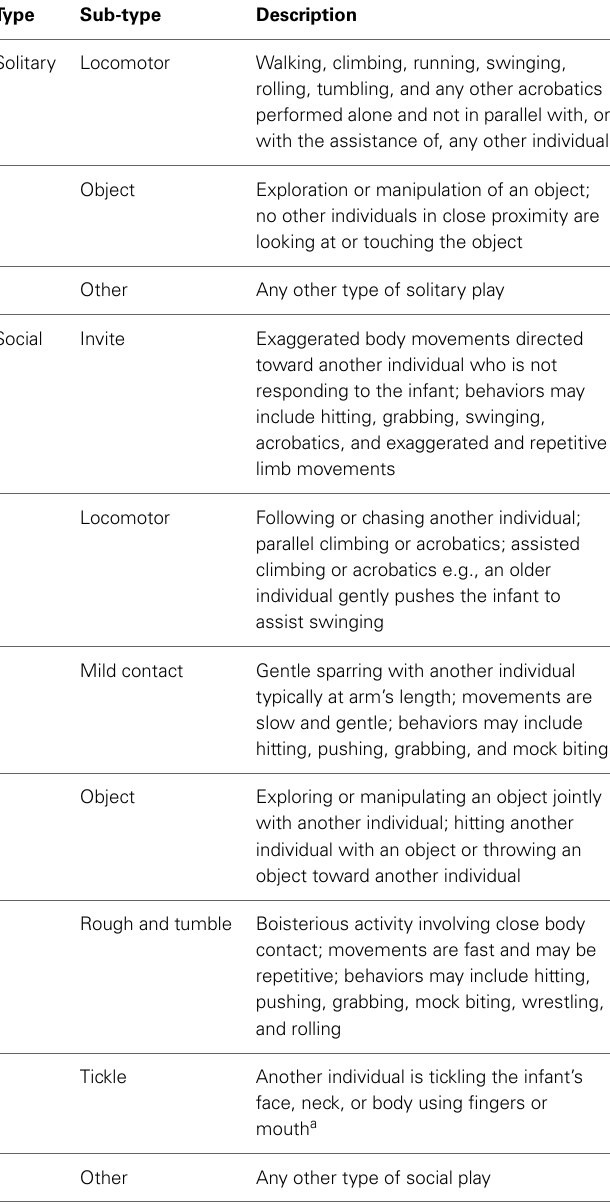
Table 2 | Description of social and solitary play